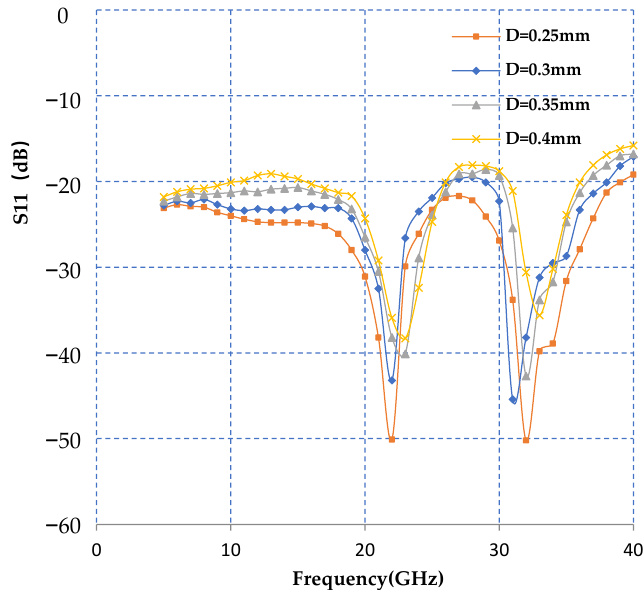
Figure 21. Tolerance analysis of the distance D between substrate edge and conductor center.